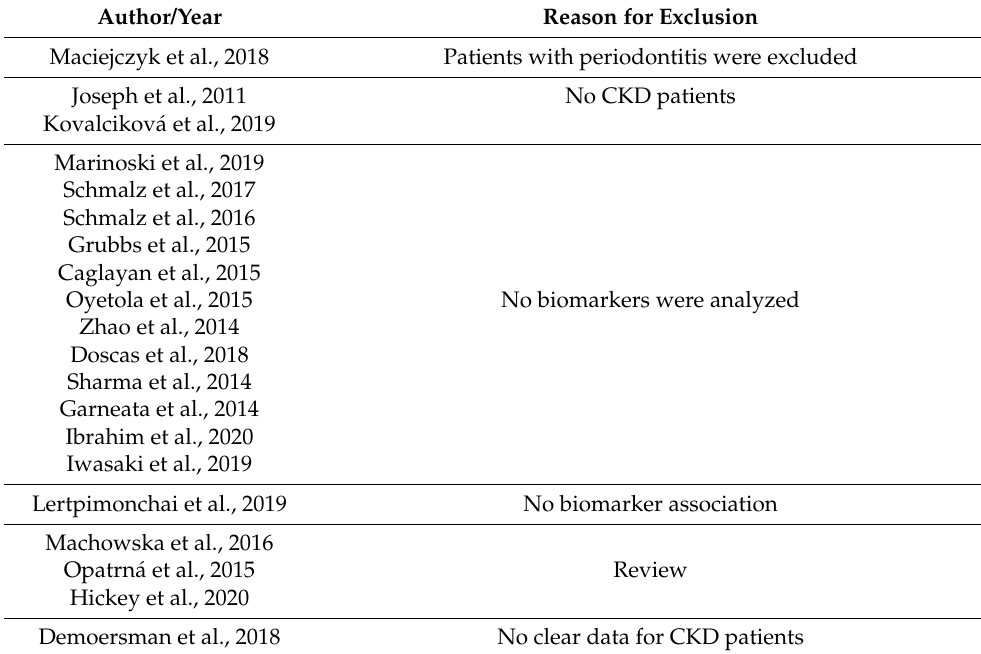
Table 3. Excluded studies and reason for